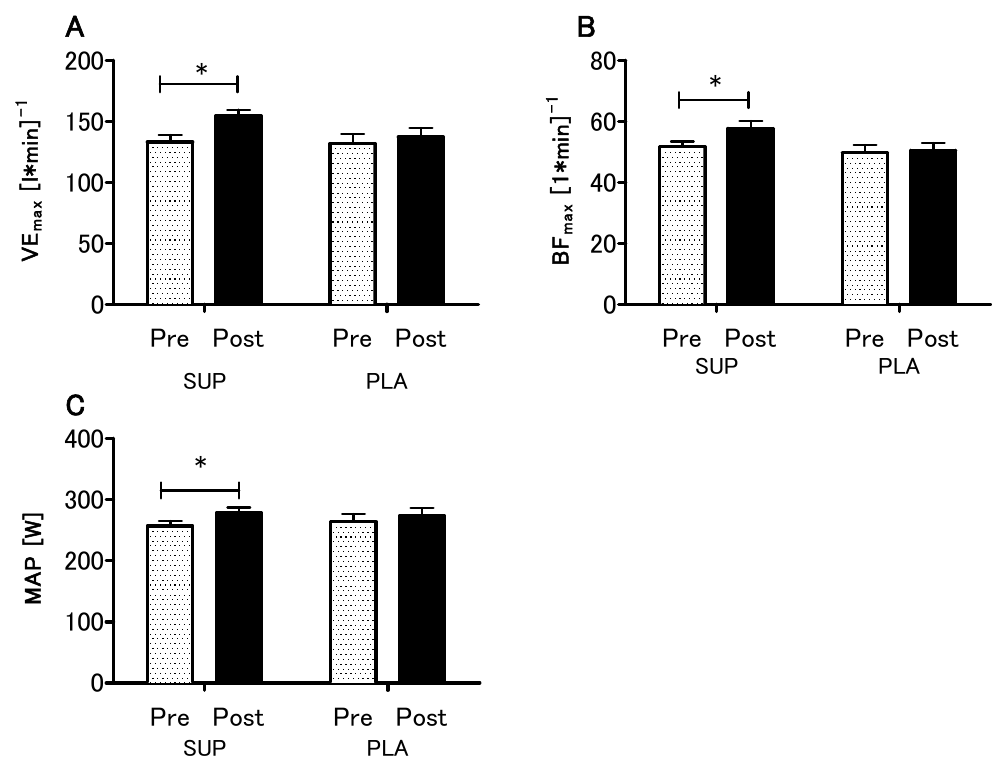
Figure 3. Effect of vitamin D supplementation on V deltas (post-pre) ( B ). Values are means. Error bars indicate ± SEM. * = p < 0.05.